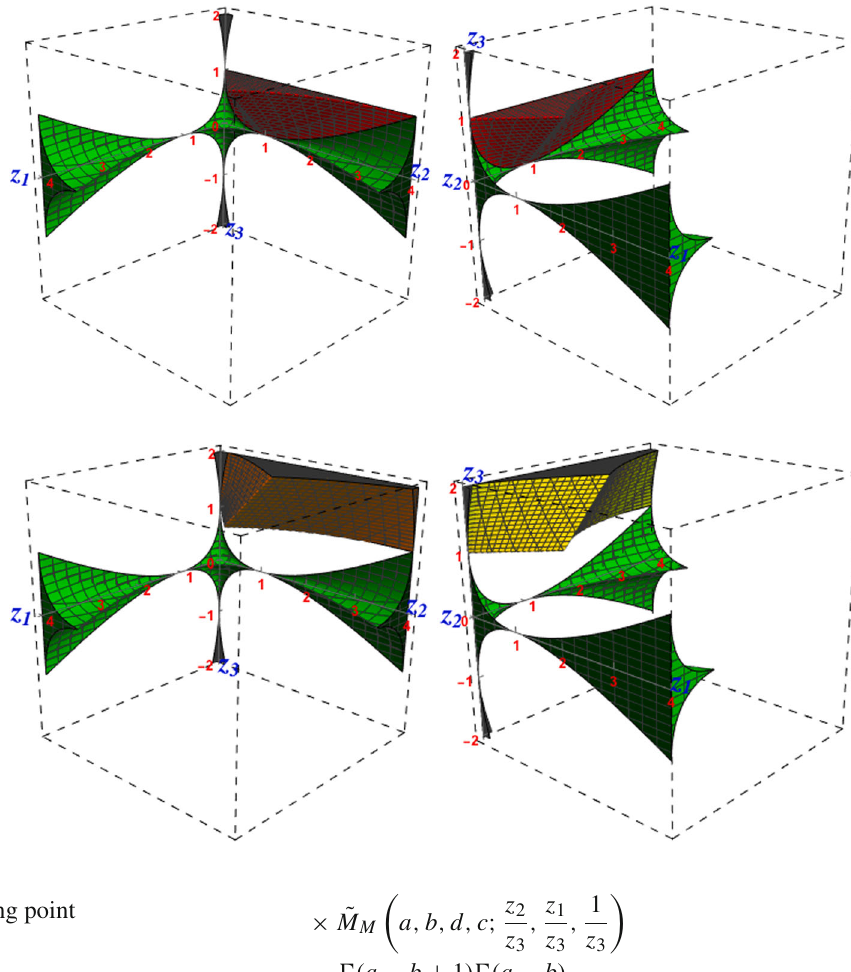
Fig. 8 Left : Region of validity ˜ R of Eqs. (34) and (57) for real z i , in red. Right : same as in left, but shown from another angle of view